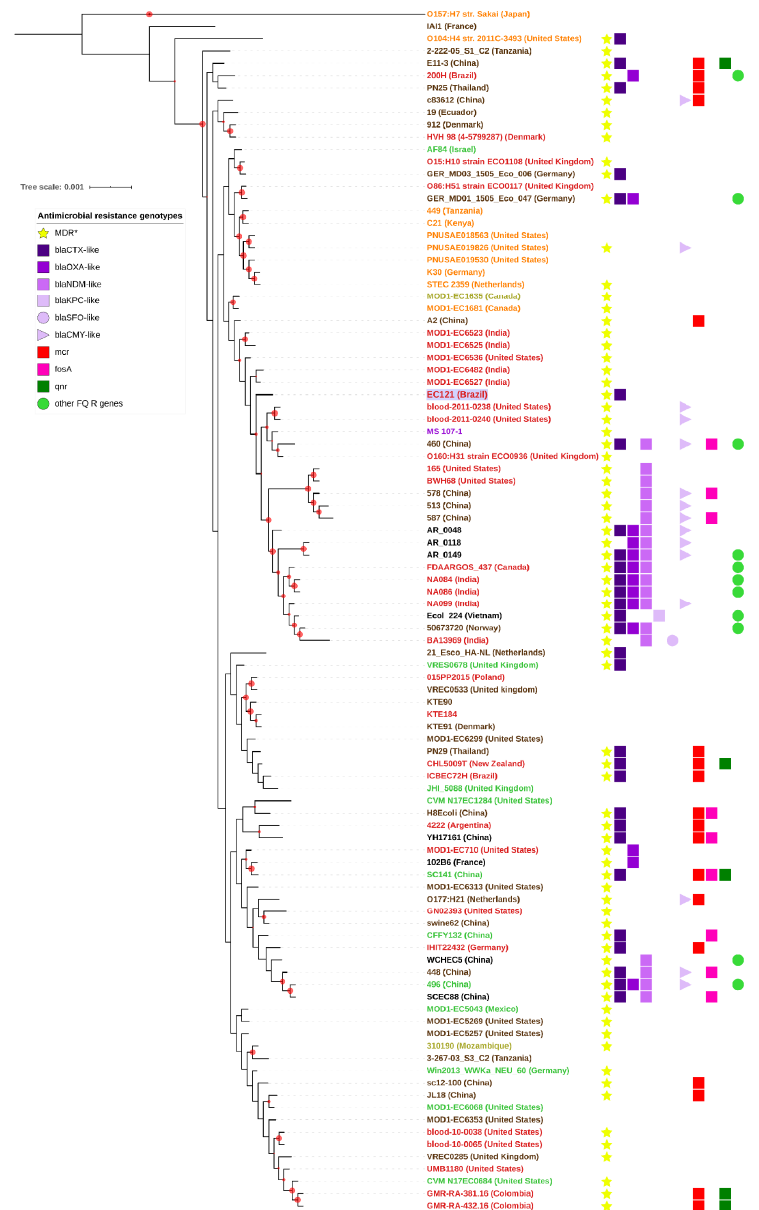
Figure 2. ST101 complex phylogenetic tree. The phylogenetic tree was built using 95 E. coli strains from the ST101 complex (ST101, ST359, ST2480, ST5957, and ST6388) from diverse sources and countries, using all shared proteins on FastTree2 to build the tree. E. coli strains IAI1, E. coli O157:H7 str Sakai, and E. coli O104:H4 str 2011c-3493 are used as outgroups. Bootstraps higher than 50 are denoted in the tree as red dots in the nodes. The strains’ names are colored according to sources or host diseases; Shiga toxin-producing E. coli (STEC) are in orange independently of the origin; diarrheagenic E. coli (DEC) strains in yellow; extraintestinal pathogenic E. coli (ExPEC) strains in red; isolates from microbiota in brown; isolates from retail food or the environment in green; strains with nonreported sources in black. A strain isolated from Crohn’s disease is in purple. EC121 is in bold and with a lilac label background. When known, the country where the strain was isolated is in parentheses. * All strains that are resistant to three or more antimicrobial classes were designed as multidrug resistant (MDR). The other FQ (fluoroquinolone) resistance genes detected were the mobile genes qepA and aac (6 (cid:48) )- Ib - cr . Mutations that confer resistance to FQ were not considered to build the antimicrobial resistance (AMR) genotype information in this